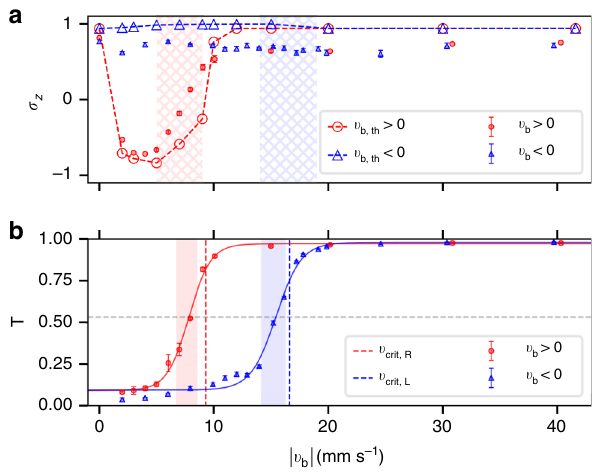
Fig. 4 Properties of unidirectional spin switch. a Spin polarization versus v b for positive (red fi lled circles) and negative (blue fi lled triangles) barrier velocities. Plotted data are mean ± s.d. for fi ve experiments at each velocity. Fig. 5 Unidirectional spin-switch mechanism. Illustration of the coupling Hatched areas indicate velocity ranges where heating was experimentally channel mechanism in the a uncoupled laboratory frame and in the b SO- observed. Numerical results for positive (red empty circles) and negative coupled comoving frame with positive (black-dashed line) or negative (blue empty triangles) barrier velocities are connected by dashed lines. (black dot-dashed line) barrier velocity. Atoms prepared in the | ↑ 〉 spin . Solid lines are sigmoidal fi ts to data b Transmission coef fi cient versus v state are coupled to the | ↓ 〉 spin state through a Raman transition (green b and the shaded regions indicate the area where the sigmoidal fi t rises from solid lines). Three channels emerge in the uncoupled system: T ↑ (brown 30% to 70%. The horizontal gray-dashed line indicates the in fl ection point squares), R ↑ (red fi lled circle), R L (red open circle); and three channels in of both fi ts at T = 0.53. GPE numerical simulations without interactions the spin-orbit-coupled system: T ↑ (brown squares), T ↓ (purple triangles), R ↓ result in sharp transitions between total re fl ection and total transmission (orange star). c Noninteracting GPE simulation of spin polarization versus (instead of a crossover region). The crossover velocity for each transition in v (interacting case in Fig. 4a). The inset shows the evolution of spin b the noninteracting case is represented by a vertical-dashed ¼ 2 mms (cid:3) 1 sweep, corresponding polarization during a highly ef fi cient v b to the interacting case in Fig. 3e. d Final quasimomentum q f (solid blue curve), and transmission coef fi cient T (black dashed), calculated from right-moving barrier can be fi t by a sigmoidal function theory for a barrier with v 0. Results from GPE simulations (orange stars mm s − 1 (solid red line in Fig. 4b). centered around 7 : 8 þ 1 : 1 (cid:3) b > 0 : 8 and brown squares) indicate the resonant channels at these velocities In the noninteracting case, numerical simulations instead indicate that a sharp transition occurs at a crossover velocity ffi 9 : 3 mm s − 1 , represented by a red vertical-dashed line v R co in Fig. 4b (see “ Methods ” and Supplementary Note 2).